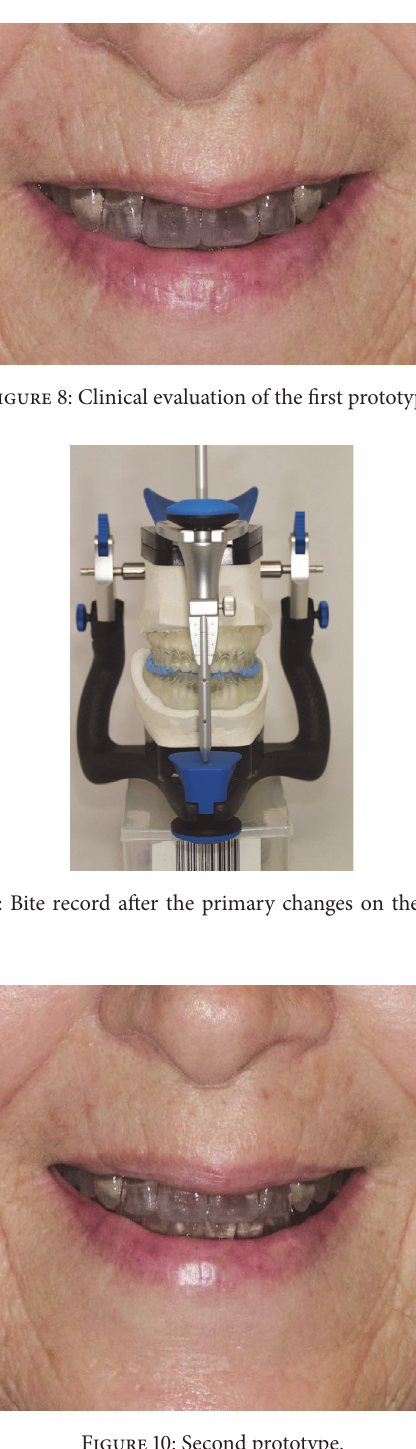
Figure 10: Second